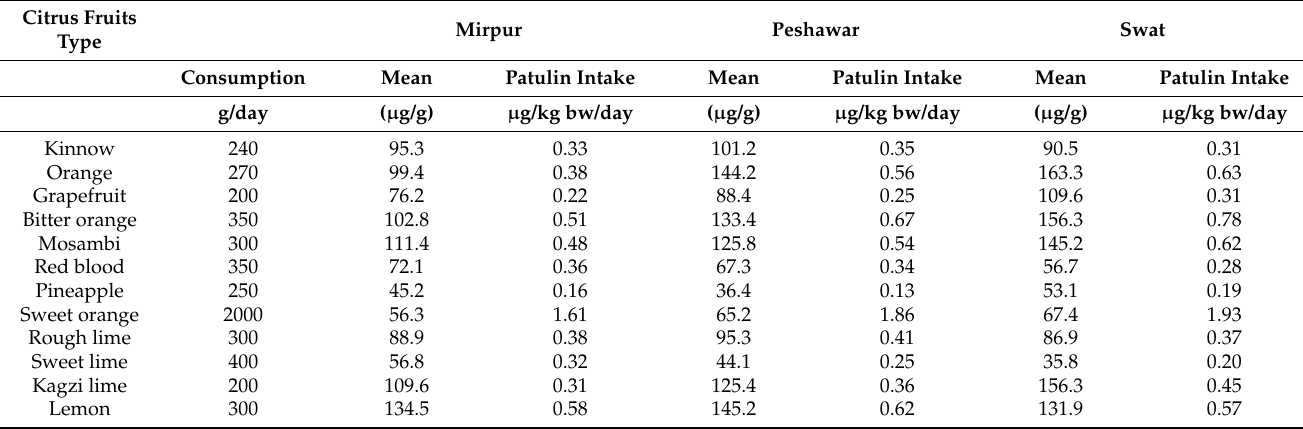
Table 6. Dietary intake of patulin in citrus fruit samples from northern areas of Pakistan. Citrus Fruits